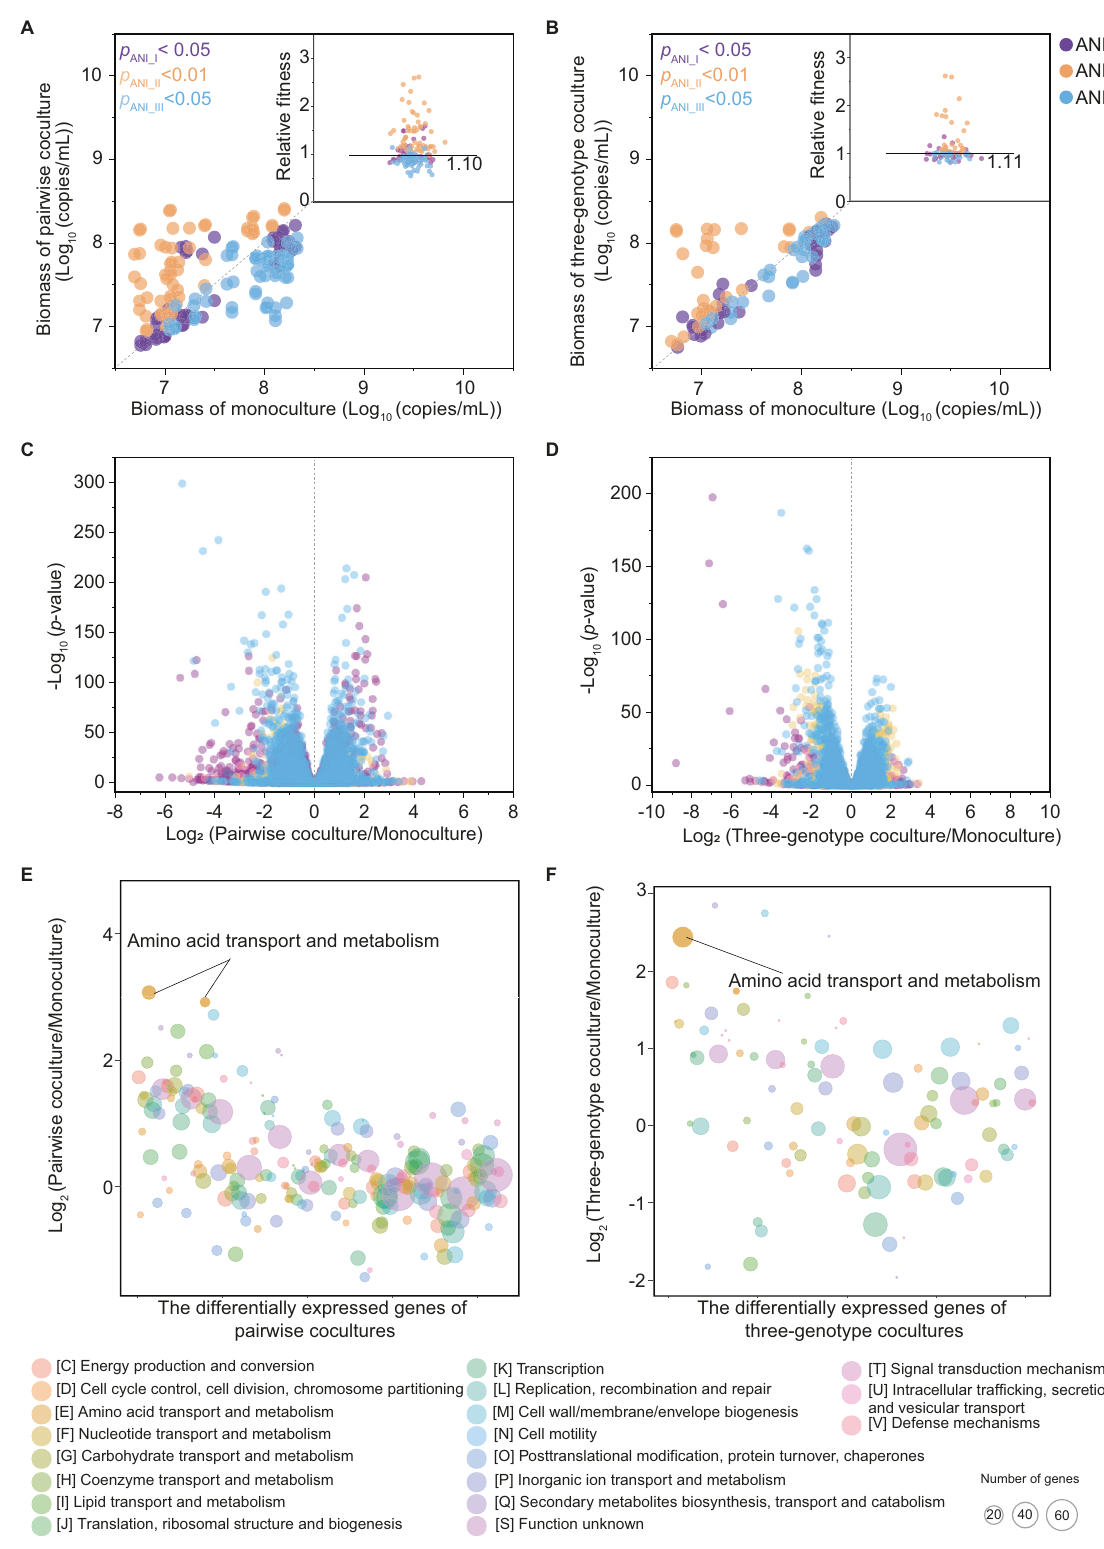
signi fi cantly decreased in pairwise and three-genotype cocultures ( t -test, p ANI_I < 0.05, p ANI_III < 0.05), and the average fi tness of ANI_I and ANI_III decreased to 0.82 and 0.56 in pairwise cocultures, and to 0.83 and 0.85 in three-genotype cocultures, respectively.